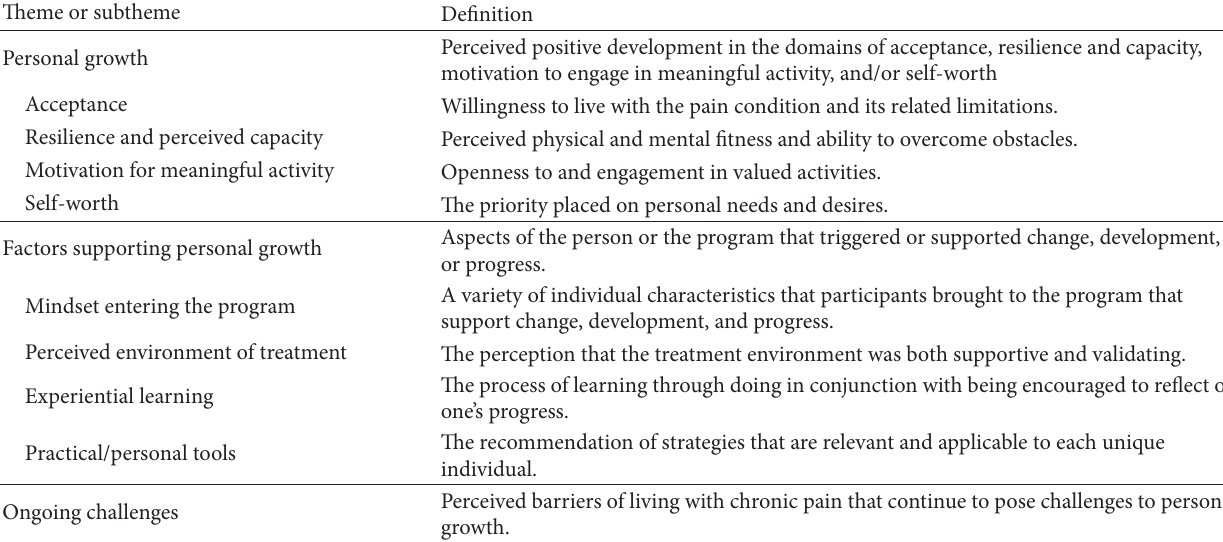
Table 1: Definitions of themes and subthemes derived from participant